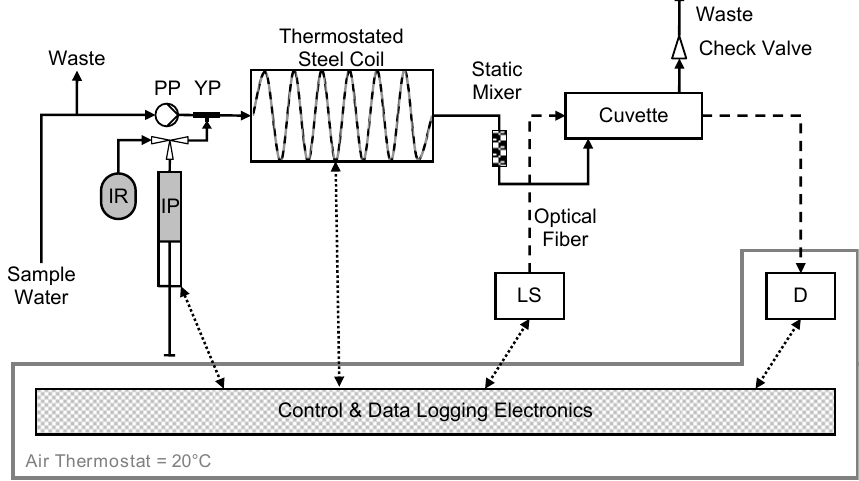
Fig. 1. Overview of the spectrophotometric pH system. IR: Indicator Reservoir, PP: Peristaltic Pump, IP: Indicator Pump, YP: Y-piece, LS: Light Source, D: Detector. The steel coil is embedded in an aluminum body providing a temperature regulation of the continuous flow in the cuvette to 25 ◦ C ± 0.006 ◦ C (1 σ ). The cuvette is isolated with polystyrene for protection from environmental temperature